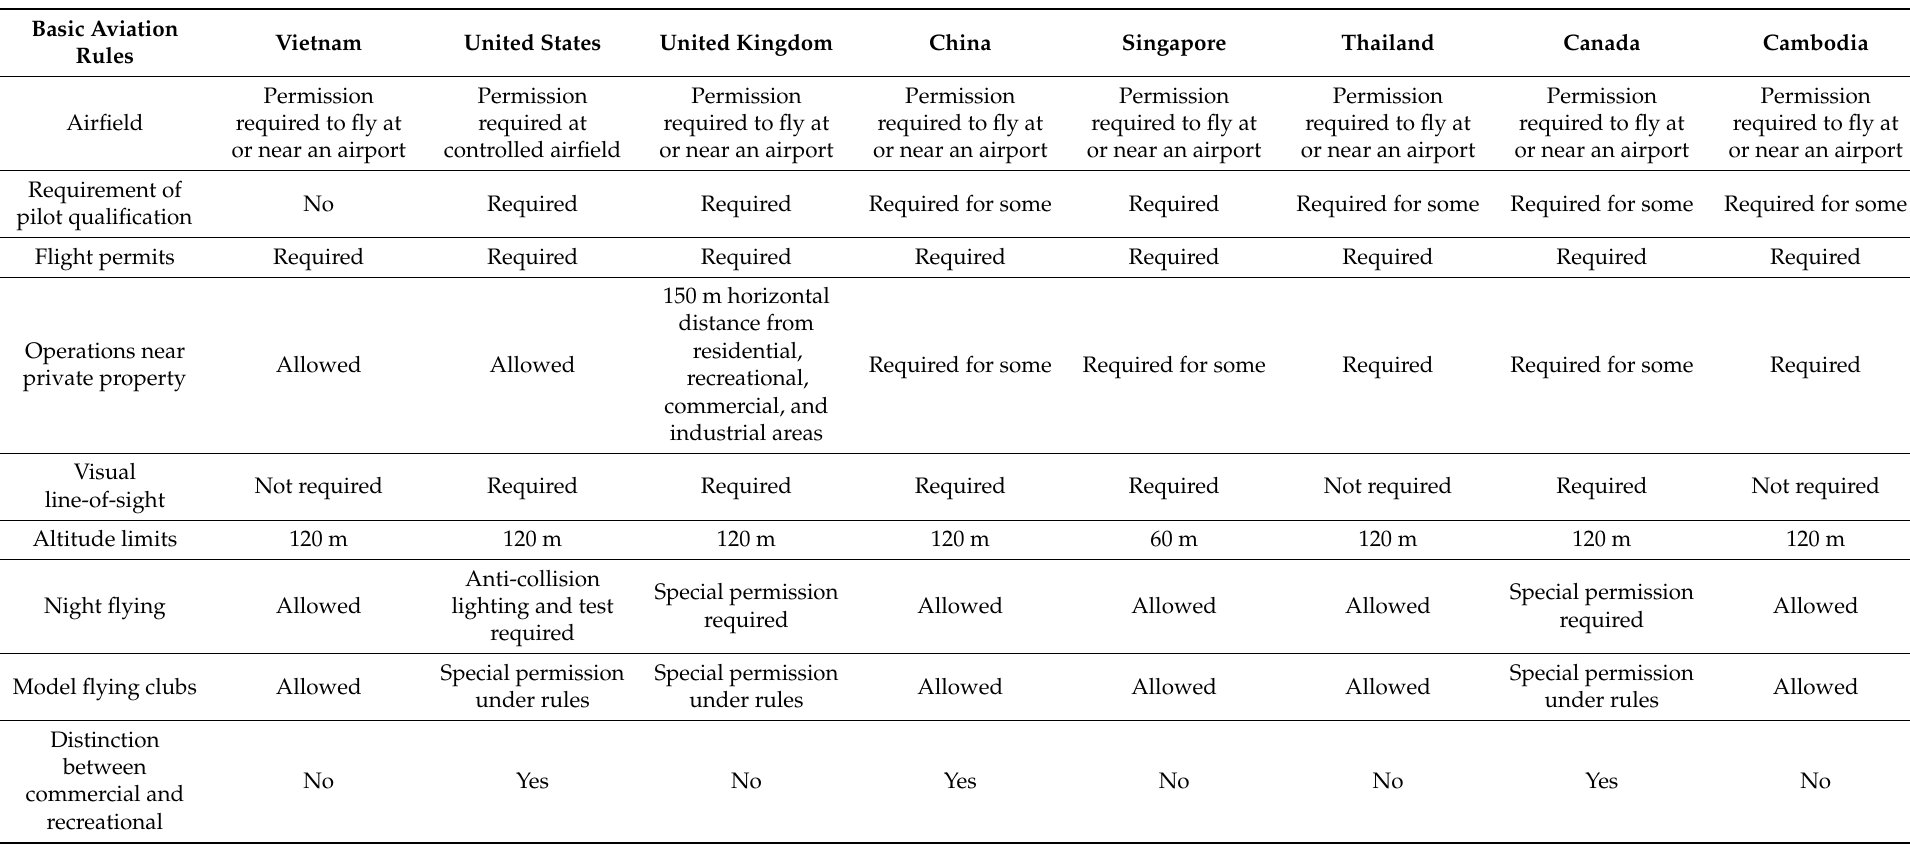
Table 2. The comparison of most basic aviation rules applied to drones in Vietnam and selected